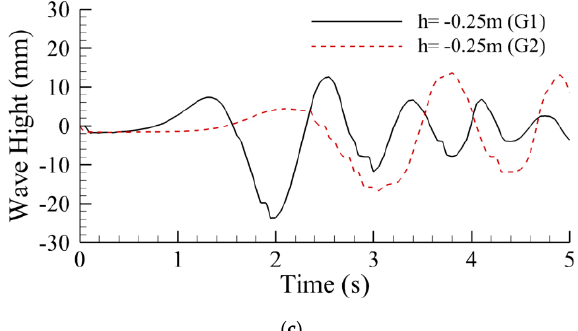
Figure 7. The temporal evolution of the water elevation in G 1 and G 2 with partial subaerial landslide: ( a ) h = 0.25 m; ( b ) h = 0.15 m; and ( c ) h = − 0.05 m.